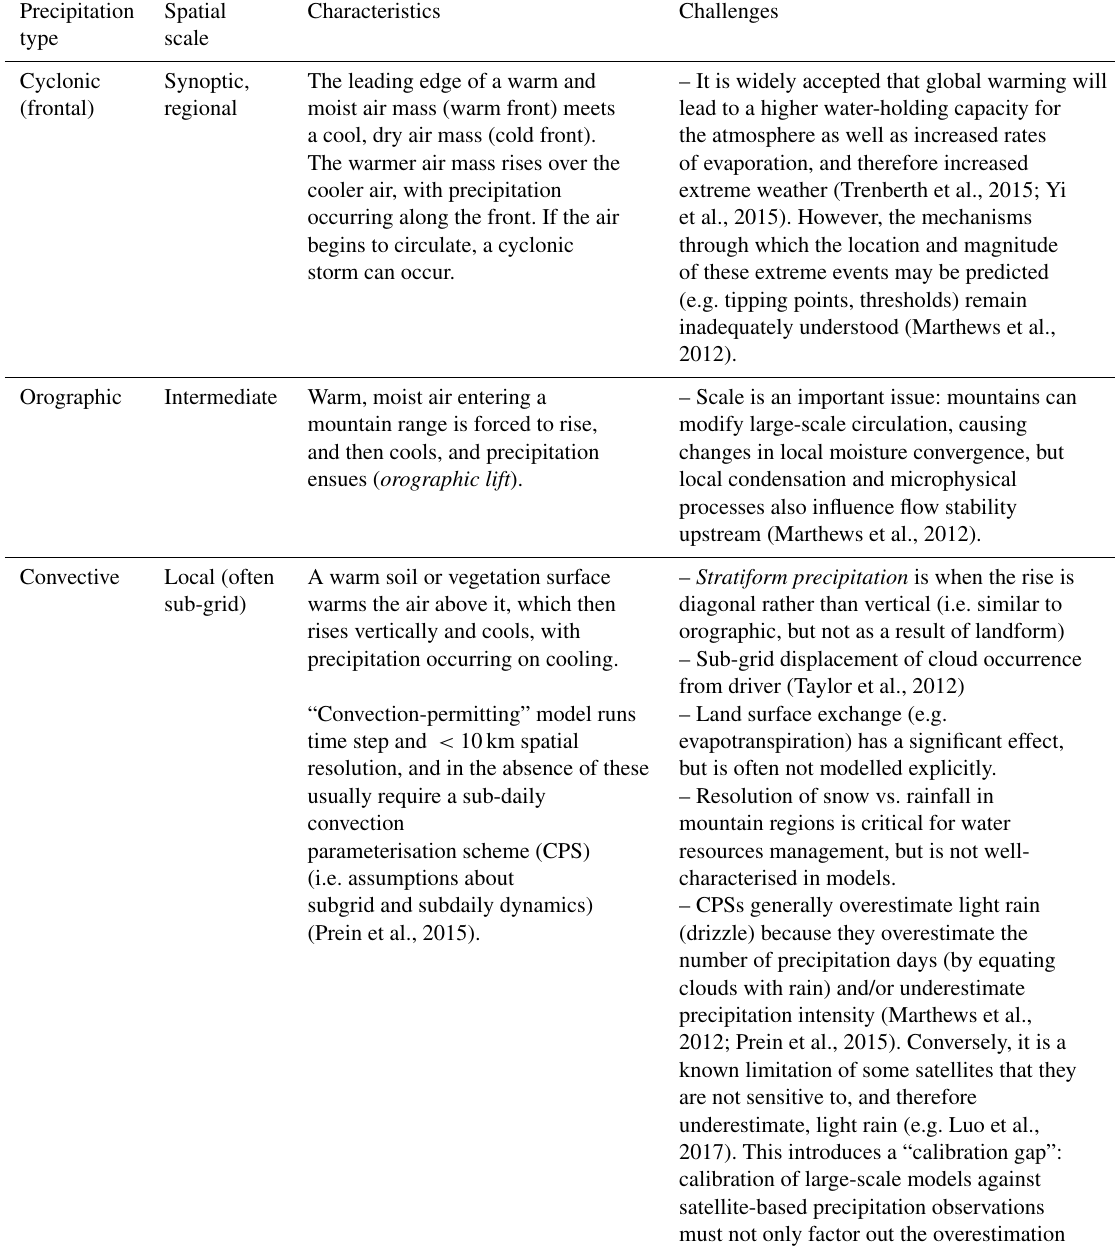
Table 1. Types of precipitation and their main controlling factors (McGregor and Nieuwolt, 1998). Precipitation Spatial